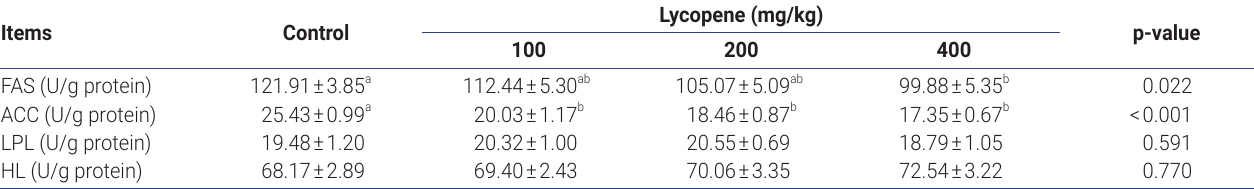
Table 6. Effects of lycopene on hepatic enzymatic activity of broiler chickens Items